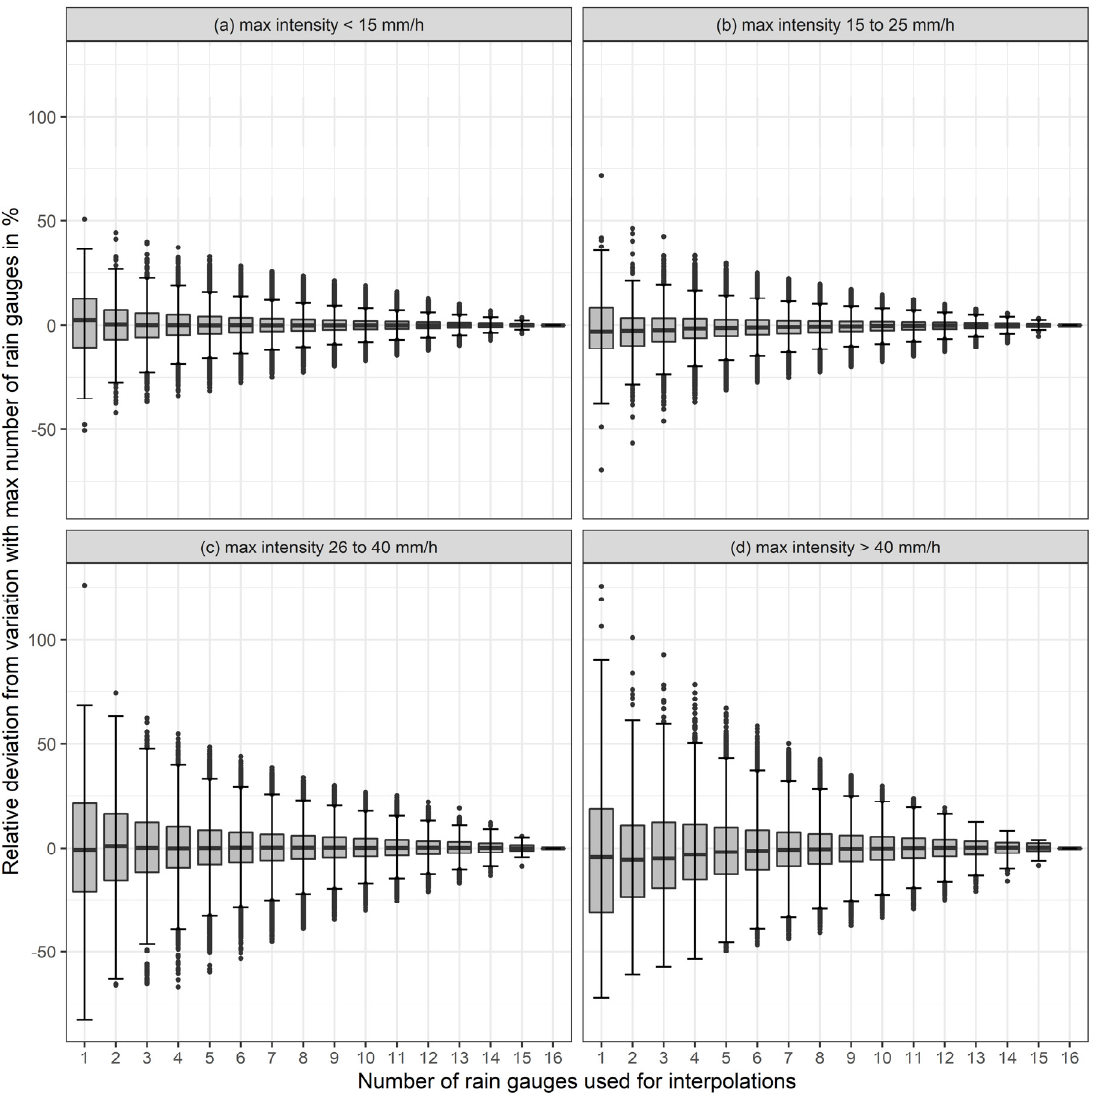
Figure 4. Relative deviations of the mean rainfalls (calculated from spatial interpolations of rainfall events) from the mean rainfall calculated from the spatial interpolation with the highest rain gauge density (all available rain gauges used as sample size). The mean rainfalls are shown as boxplots grouped by the used sample size for the spatial interpolation of the event rainfall. ( a – d ) are equally sized groups of events grouped by their maximum hourly intensity measured during each event.